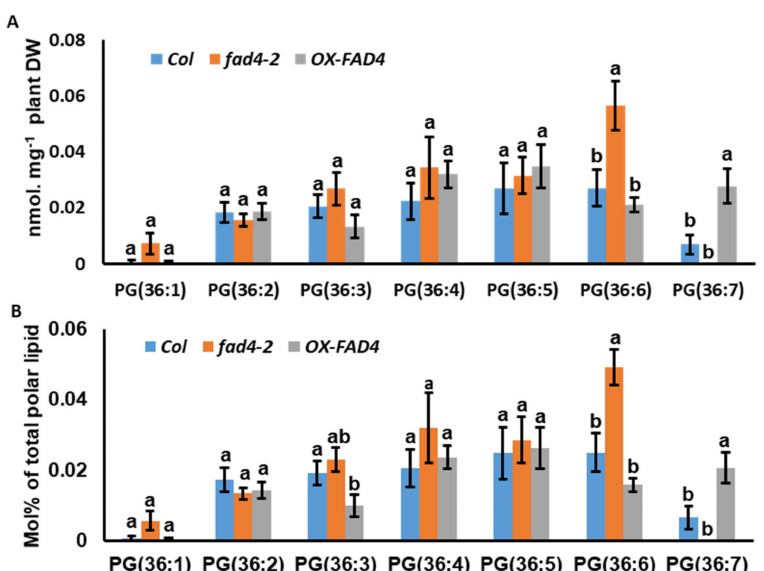
Figure 6. PG (36) contents and Mol % distribution from total polar lipids of WT, fad42 , and OXFAD4_2 plants. ( A ) PG (36) contents from WT, fad42 , and OXFAD4_2 . ( B ) PG (36) Mol % distribution from total polar lipids of WT, fad42 , and OXFAD4_2 . Data were expressed as mean ± standard error (n = 5). Different letters within same molecular species represent statistically significant